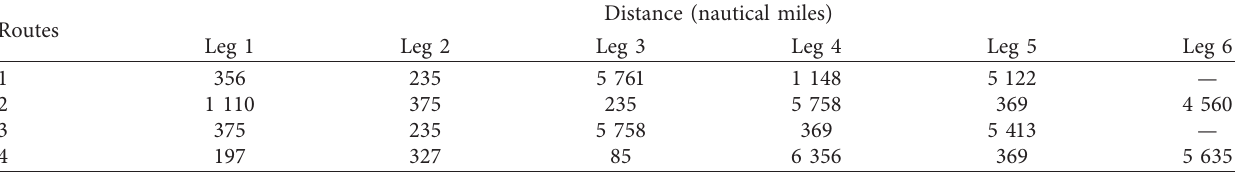
Table 3: Oceanic distance of each leg on each liner route.